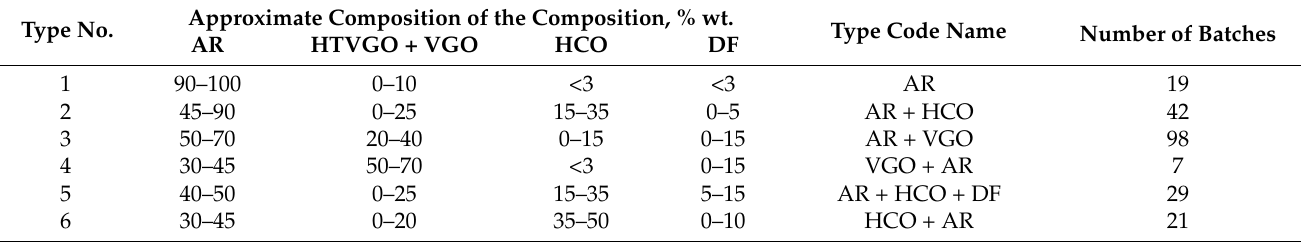
Table 14. Distribution of shipments of Western European ports by type